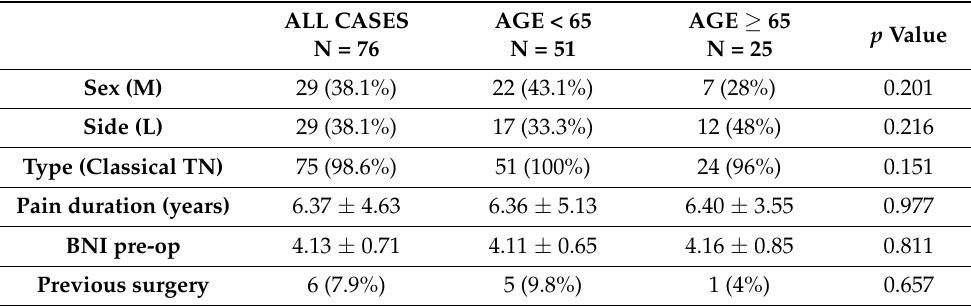
Table 1. Patients (cid:48) demographics and clinical characteristics.